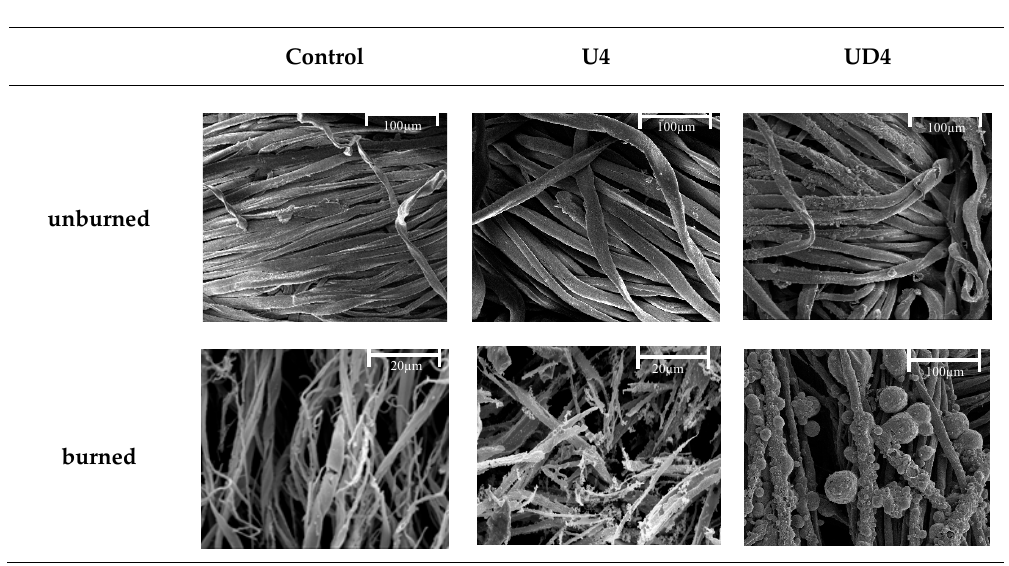
Figure 5. SEM micrographs of 1500× of the before burned ( top ) and after burned ( bottom ) for control, U4 and UD4.